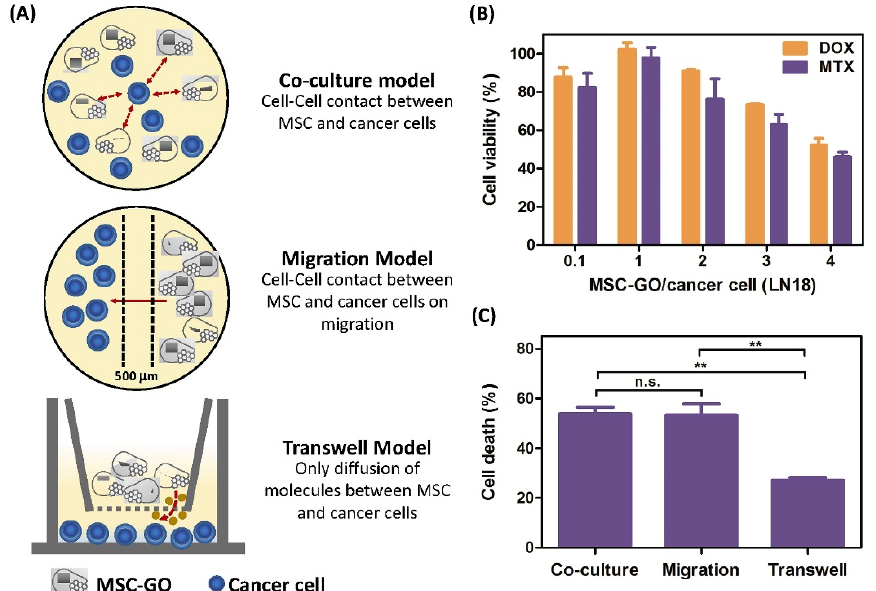
Figure 4. The effects of GO based drug delivery systems on MSCs: ( A ) The function of three different toxicity models, ( B ) the assessment of cancer cell (LN18) viability upon the loading of two different drugs in various amounts, ( C ) cancer cell (LN18) toxicity evaluation of the three models presented in ( A ) (where n = 3; significance: ** p < 0.01; n.s.: not significant; determined by One-way ANOVA)